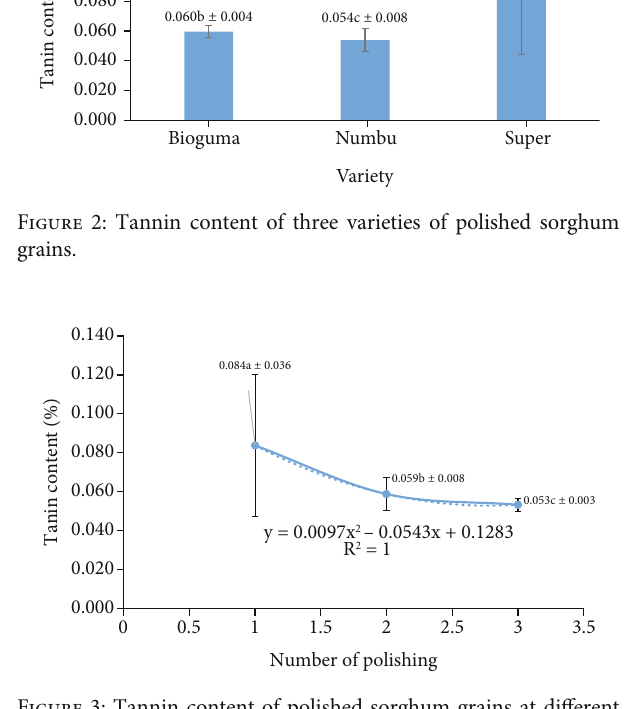
Figure 3: Tannin content of polished sorghum grains at di ff erent polishing frequencies.